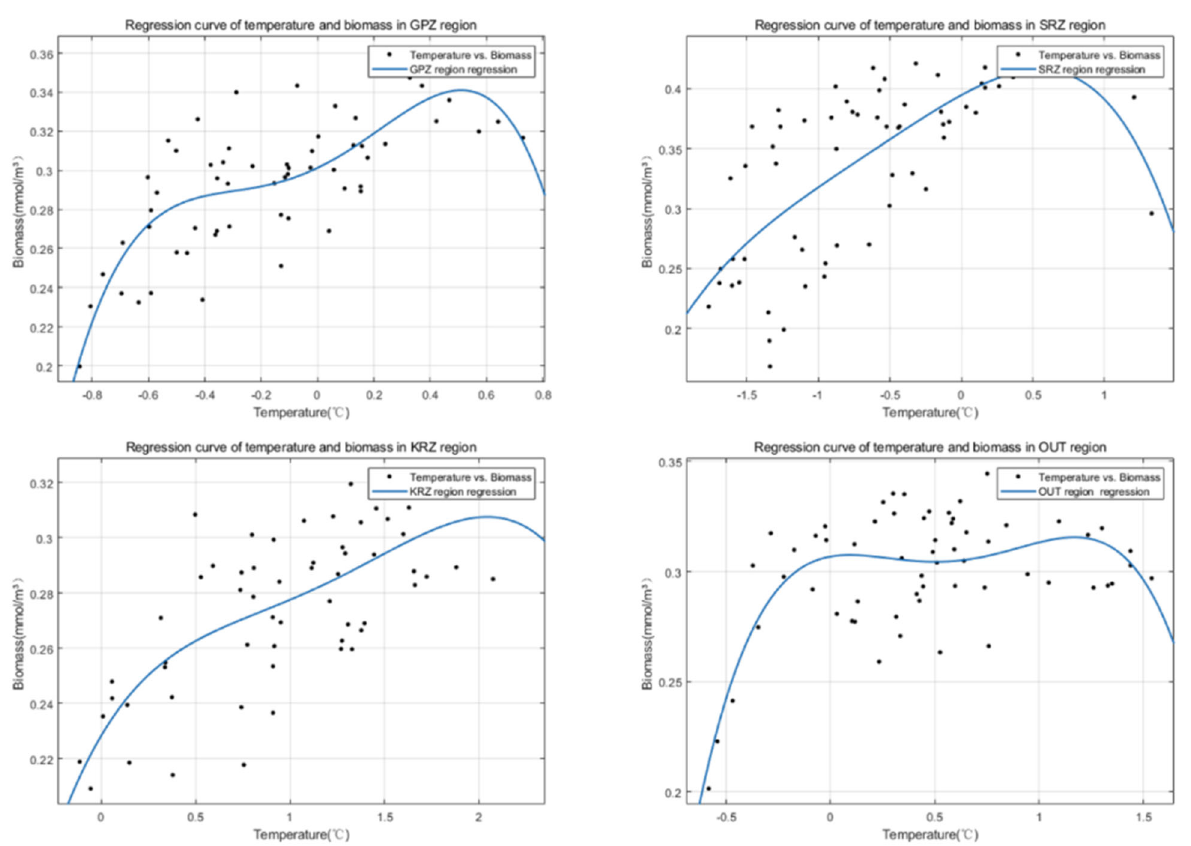
Figure 10. Regression curves of temperature vs. biomass in four MPA regions. (Polynomial function with 4 degrees).